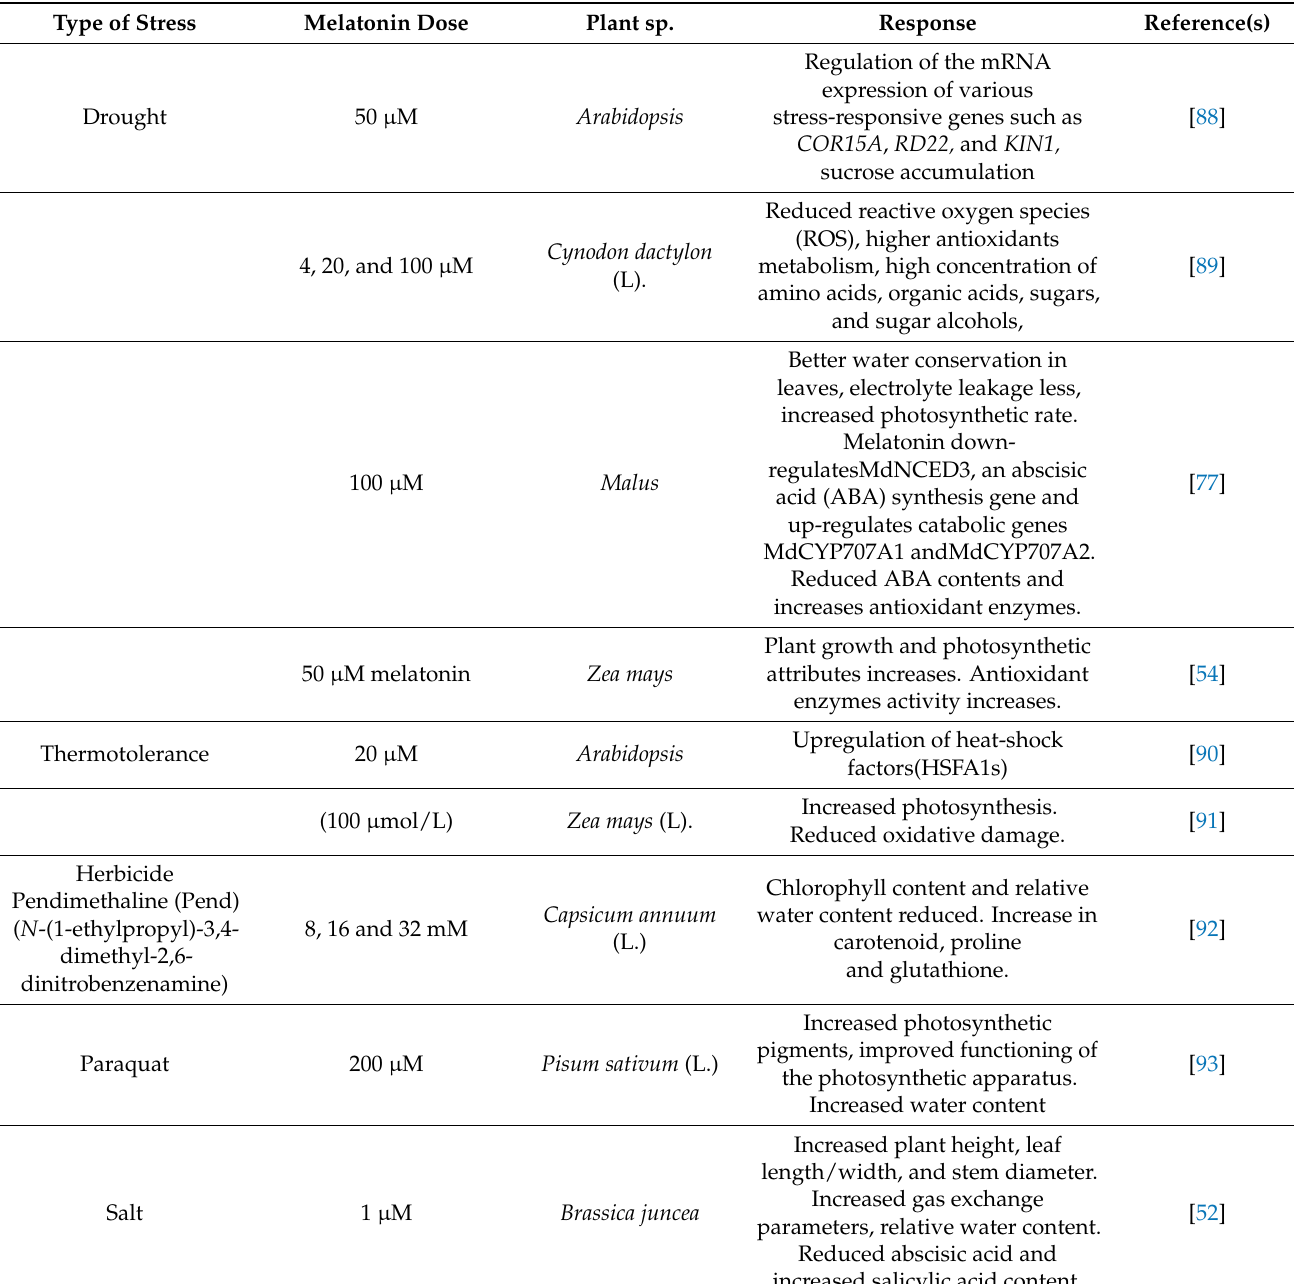
Table 2. Melatonin functioning under different stress